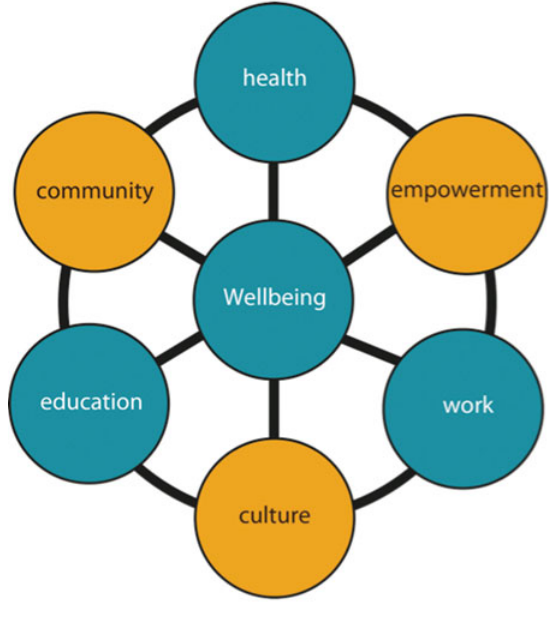
FIGURE 1 (Colour online) The Interplay Wellbeing